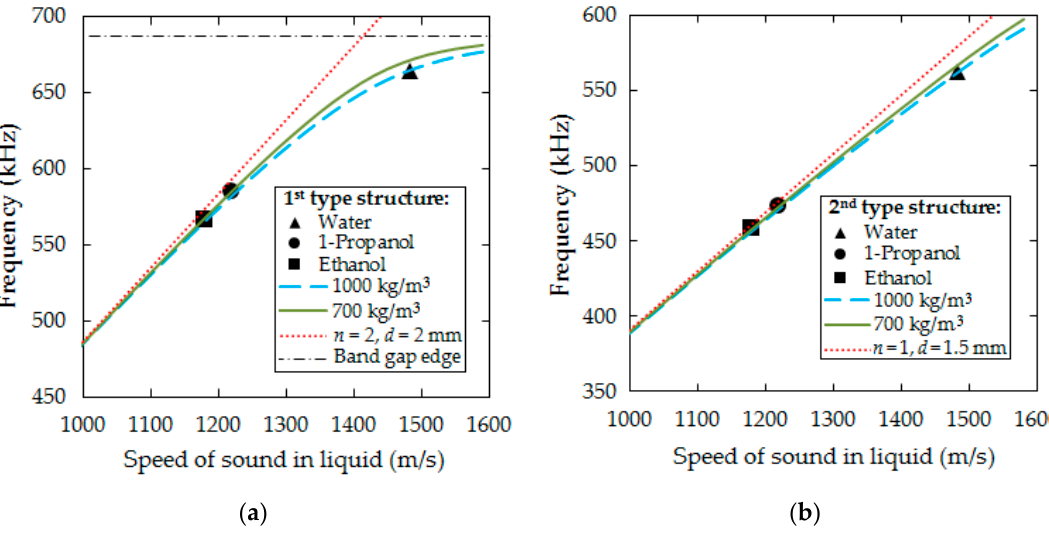
Figure 7. Dependence of the resonant frequency of the sensor on sound velocity of the liquid for two values of liquid density: ( a ) First type sensor; ( b ) second type sensor. The curves show the results of theoretical calculations, the markers show the results of experimental measurements for water, 1-propanol and ethanol. The red dotted lines show the dependence for the n -resonant mode of a cylindrical liquid-filled resonator of diameter d with perfectly reflective walls.